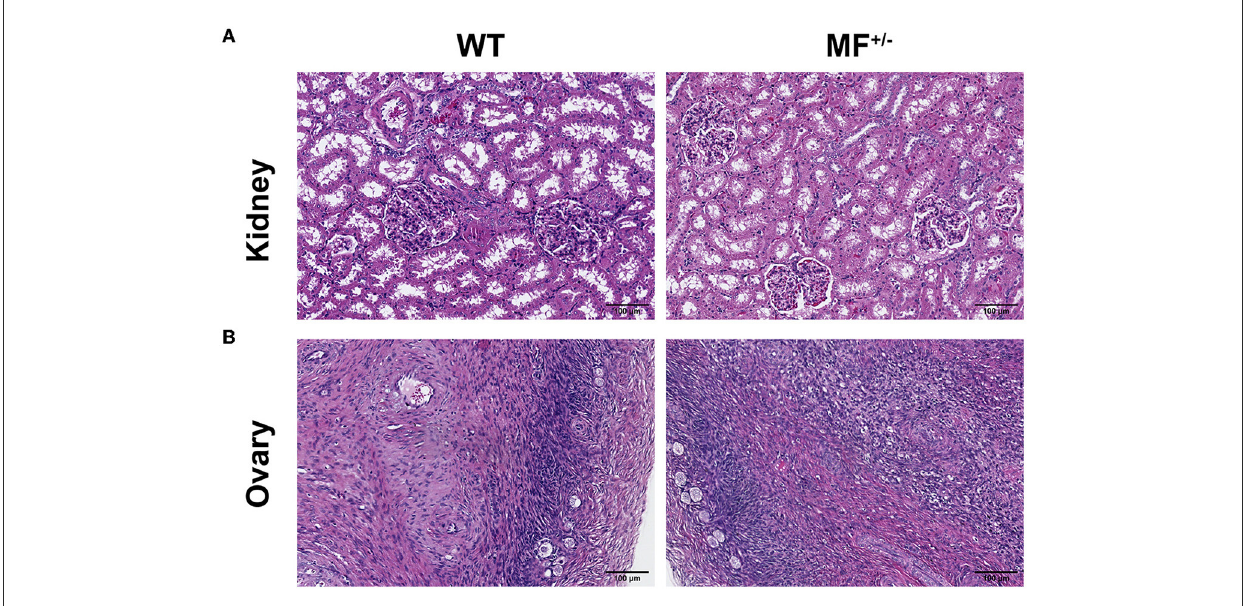
FIGURE4 Histological analysis of kidney and ovary in WT and MF +/- sheep. (A, B) Representative pictures of HE staining of kidney (A) and ovary (B) in 12-month-old WT and MF +/– sheep. Scale bar 100 µ m.